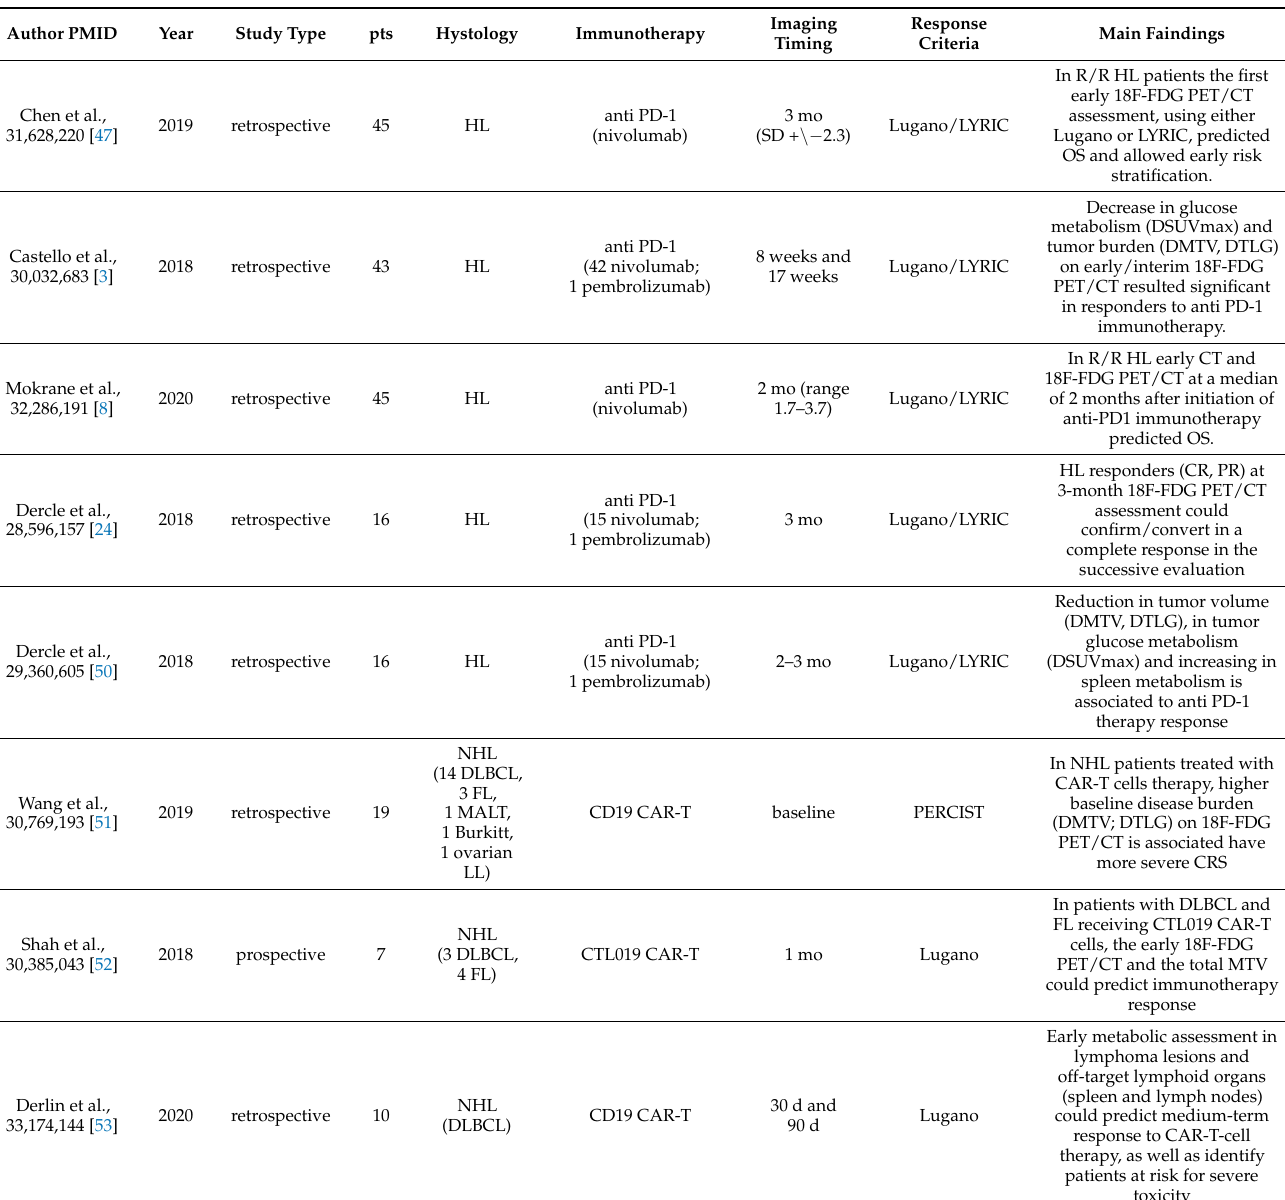
Table 2. Characteristics of original articles